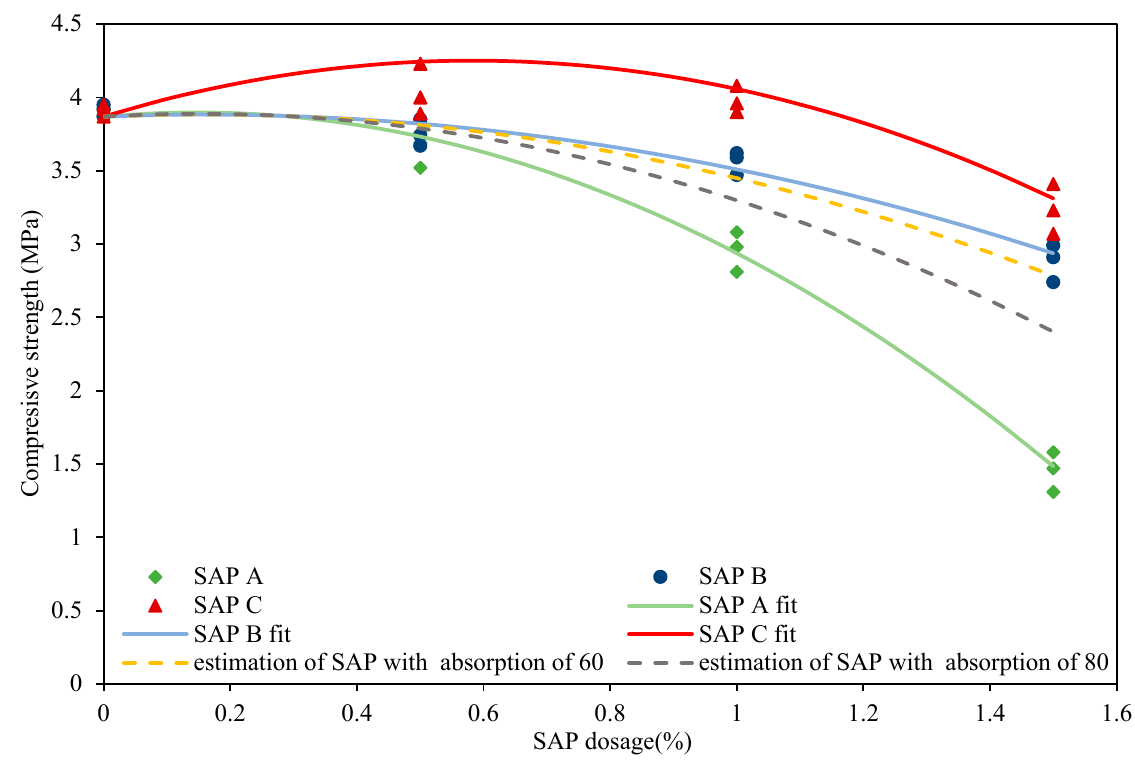
Figure 10. Analytical expressions of the dependence of compressive strength of studied lime-based plasters on SAP dosage and SAP water absorption capacity.